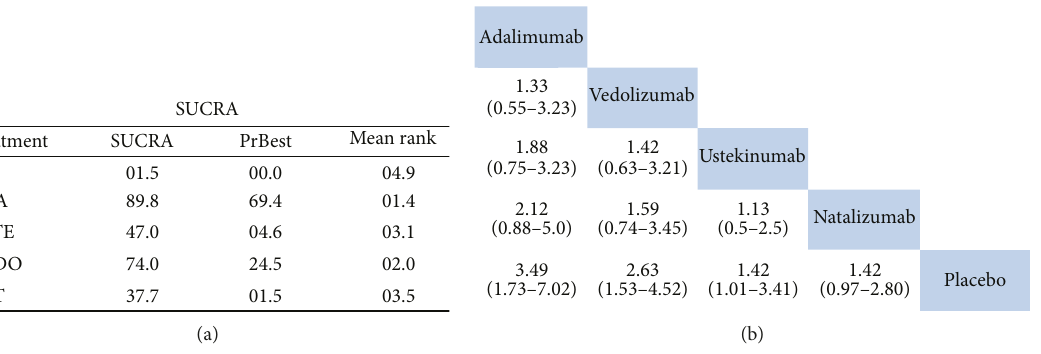
Figure 5: Network meta-analysis and ranking of treatments for inducing remission in anti-TNF-experienced CD patients via (a) SUCRA analysis and (b) league table graph. Odds ratios (ORs) with 95% con fi dence interval (CI) are reported. ADA=adalimumab; USTE=ustekinumab; VEDO=vedolizumab; NAT=natalizumab; PL =placebo.